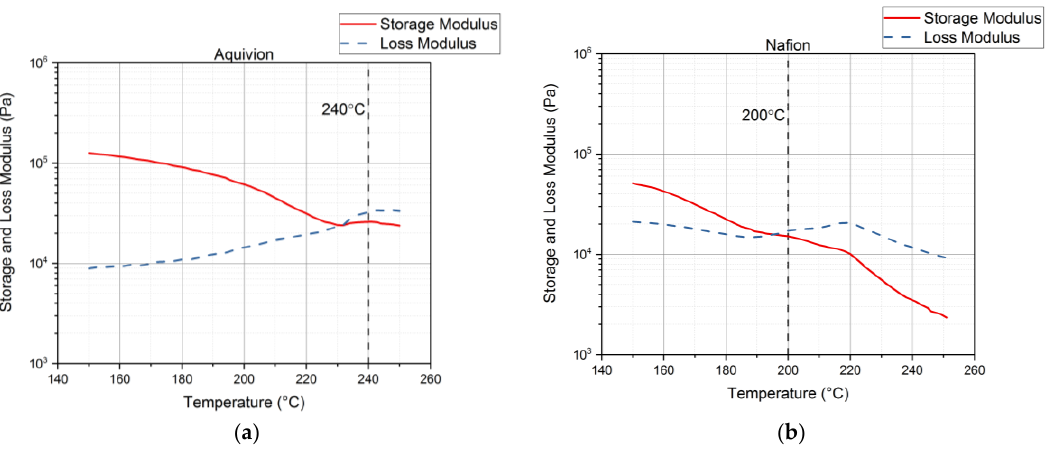
Figure 9. Results from the rheology tests showing the melting temperature of precursor Aquivion ( a ) and precursor Nafion ( b ).